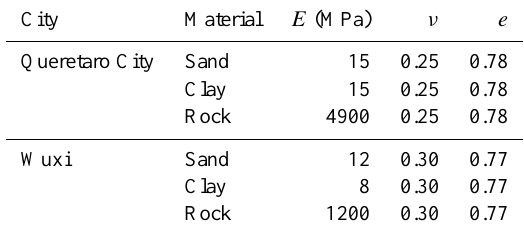
Table 1. Geomechanical properties used for the two test cases. E : Young modulus; ν : Poisson’s ratio; e : void